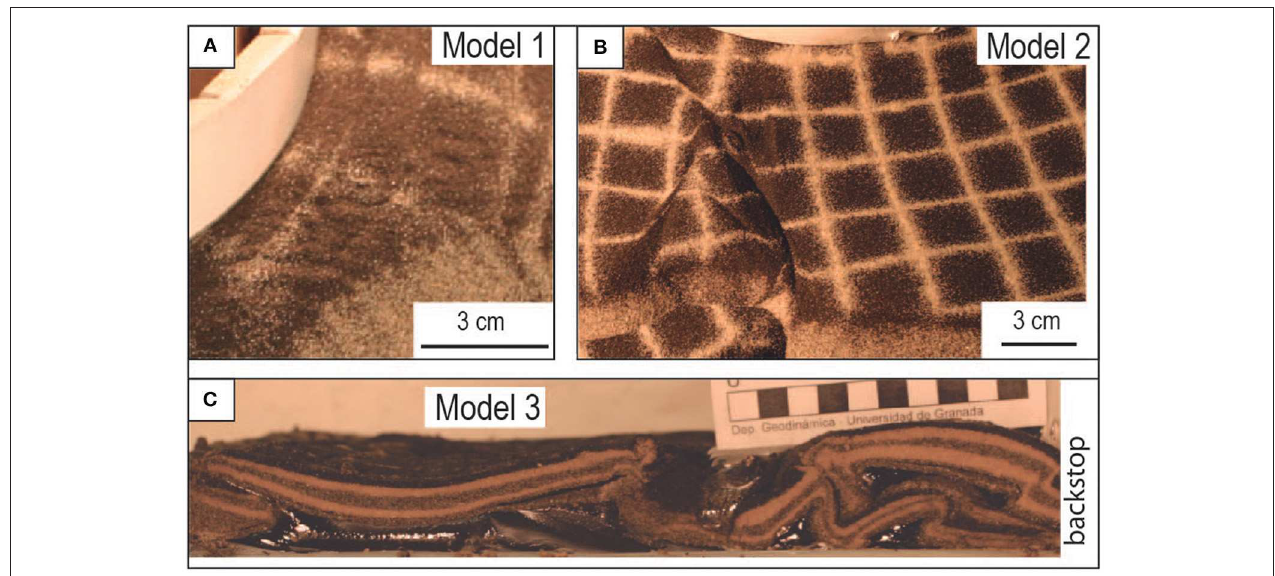
FIGURE 4 | Photographs of various models. (A) Model 1: millimetrical-spaced normal faults (situated to the right of Fault 7 in Figure 3A ). (B) Model 2: Conjugated strike-slip faults system and small normal faults (situated to the right of Fault 11 in Figure 5B ). (C) Cross section in the arc apex zone of Model 3 (location on Figure 5F